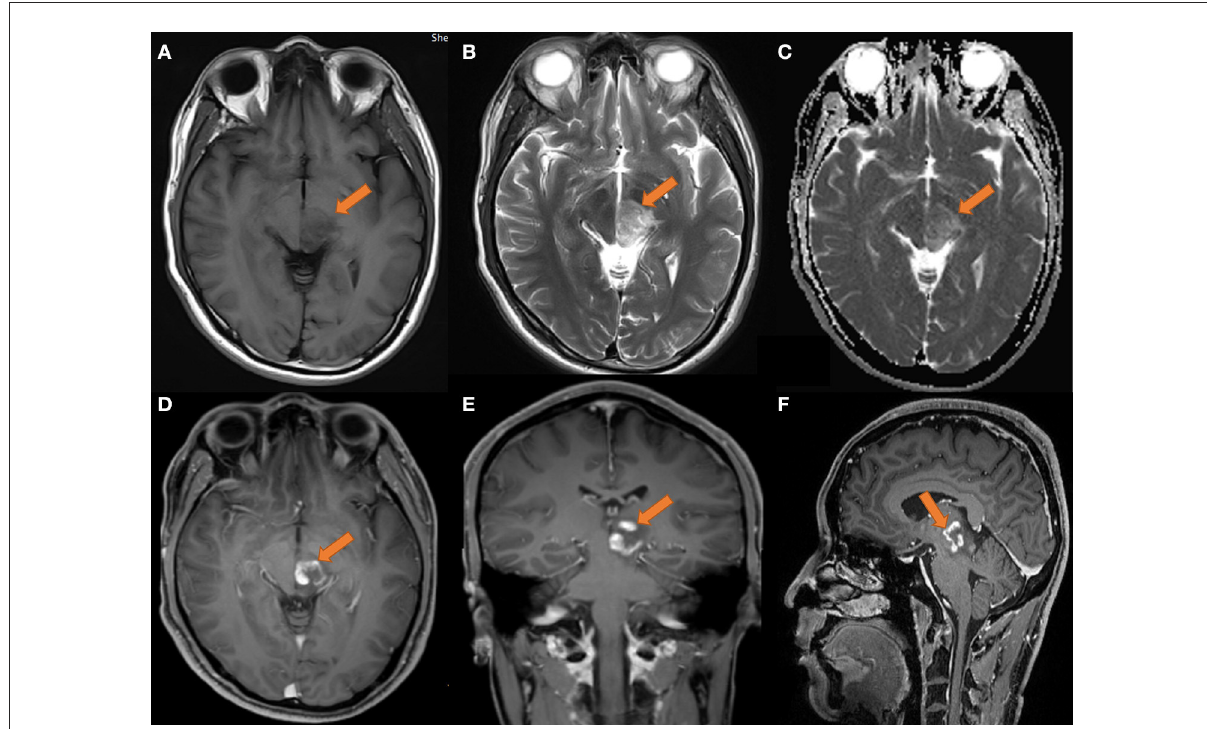
FIGURE1 MRI of the head on 2019-08-14. (A) T1 transverse view: patchy low signal mass with unclear margin in left thalamus and pons. (B) T2 transverse section: the lesions showed moderate and slightly high signal. (C) ADC showed limited diffusion; (D–F) transverse coronal